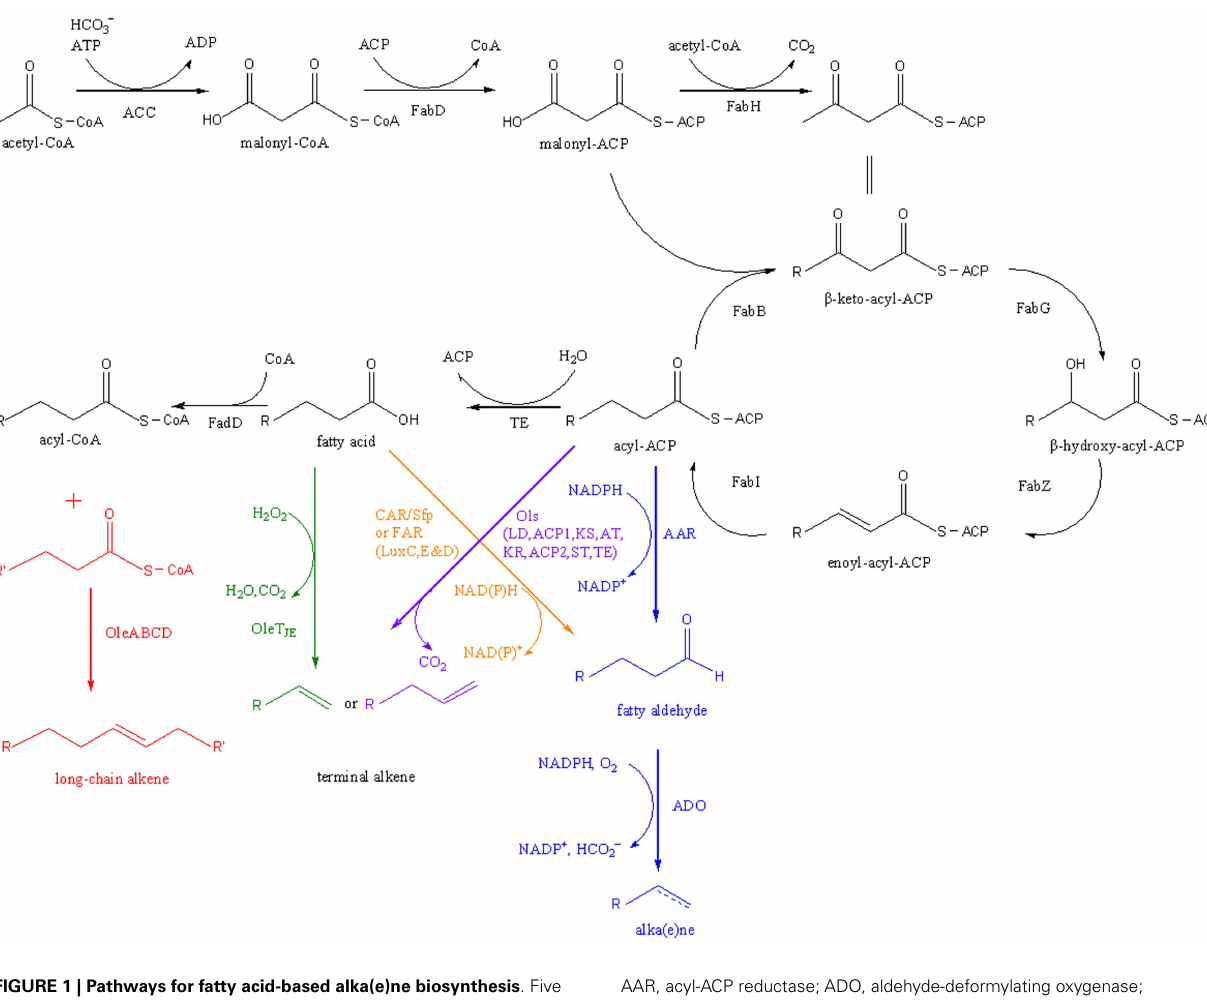
AAR, acyl-ACP reductase; ADO, aldehyde-deformylating oxygenase; OleABCD, a four protein families for long-chain olefin biosynthesis; OleT JE , a cytochrome P450 enzyme that reduces fatty acids to alkenes; CAR, carboxylic acid reductase; Sfp, A phosphopantetheinyl transferase; FAR, fatty acid reductase; Ols, a type I polyketide synthases for α -olefin